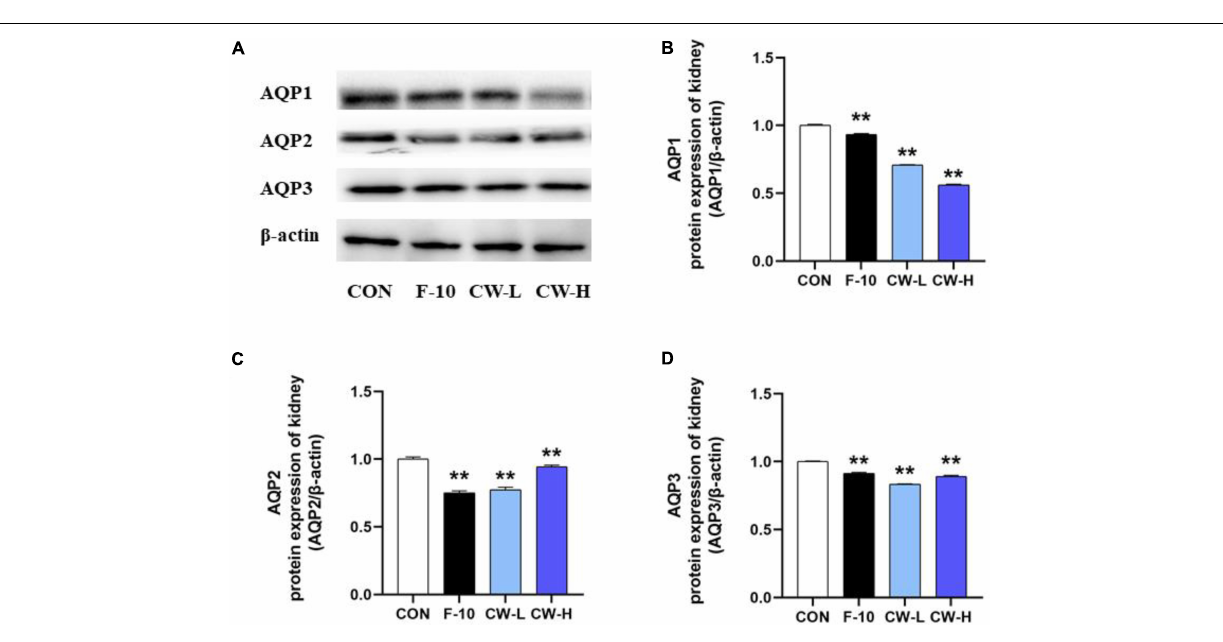
FIGURE 4 | The levels of AQP1, AQP2, and AQP3 protein expression from different groups were detected by Western blot assay, and representative bands are shown in (A) . The levels of AQP1 (B) , AQP2 (C) , and AQP3 (D) were normalized to the model group. Values expressed as mean ± SD ( n = 3), ** p < 0.01 compared to the control